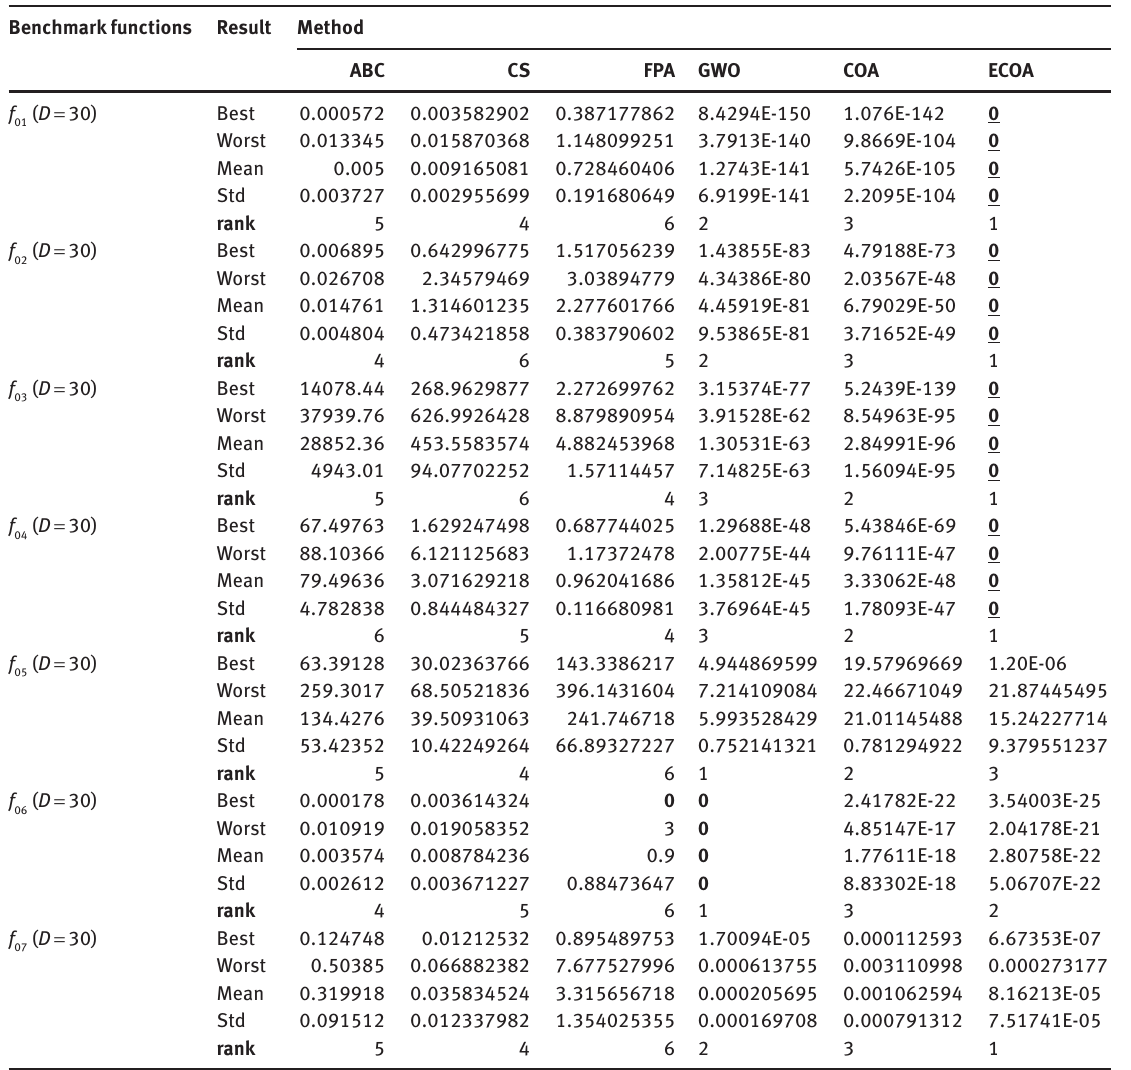
, i = 1, 2, 3, 4, 5, 6, 7. i